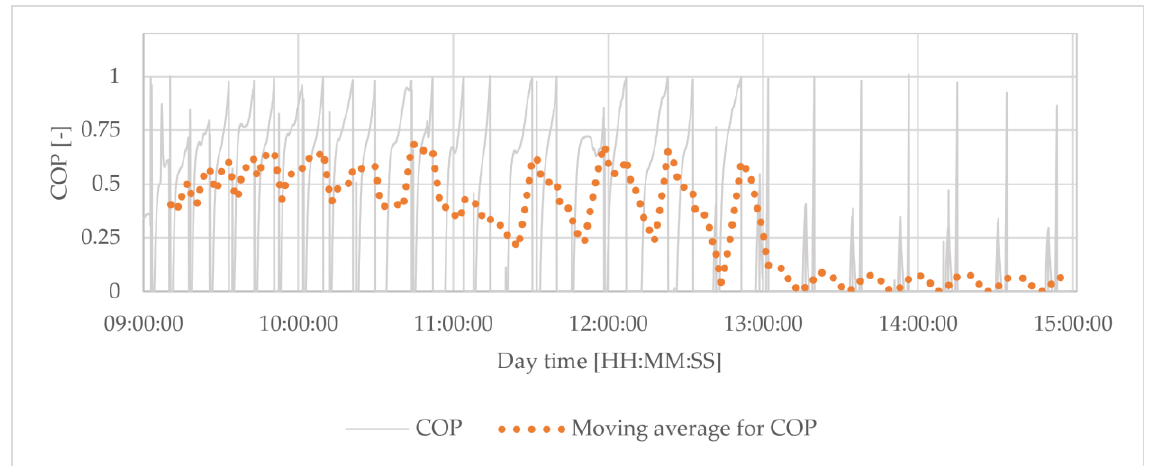
Figure 17. COP values over time for 6th August.